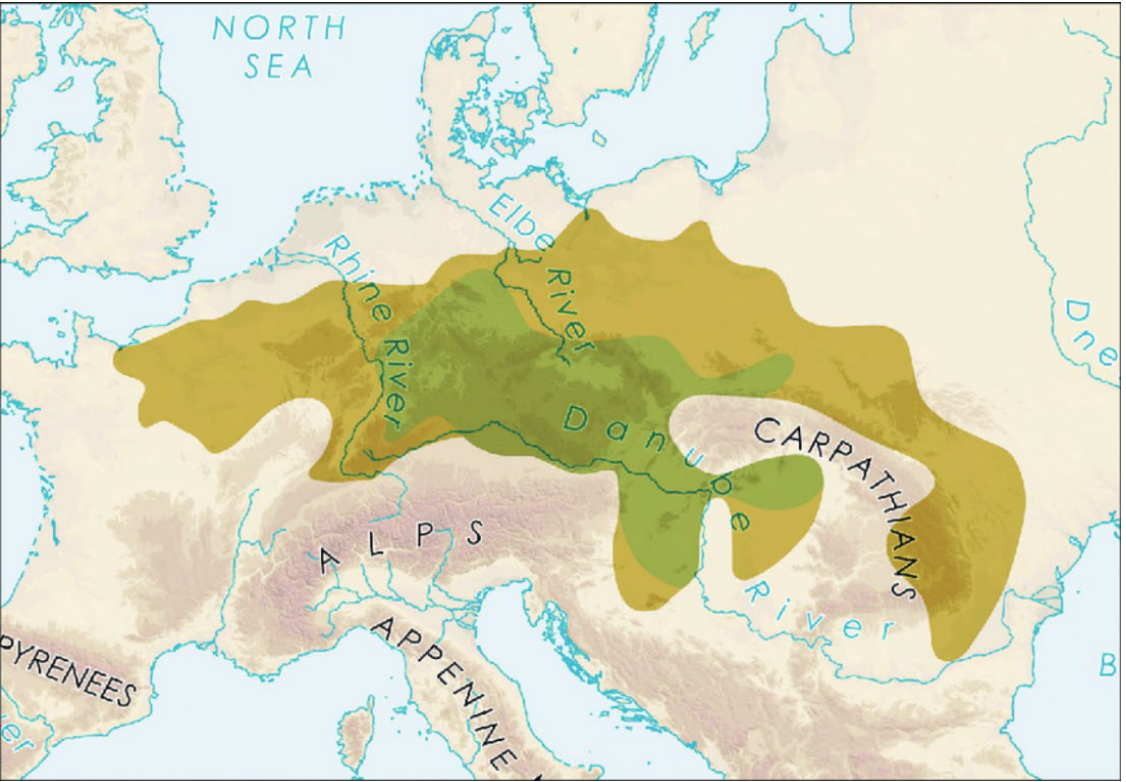
Figure 1. Map showing the distribution of the first farmers (Linear Pottery Culture) in Central Europe (S. Hansen, modified by E. Bánffy 2015). Green: Earliest Linear Pottery Culture; yellow: maximum extension of the Linear Pottery